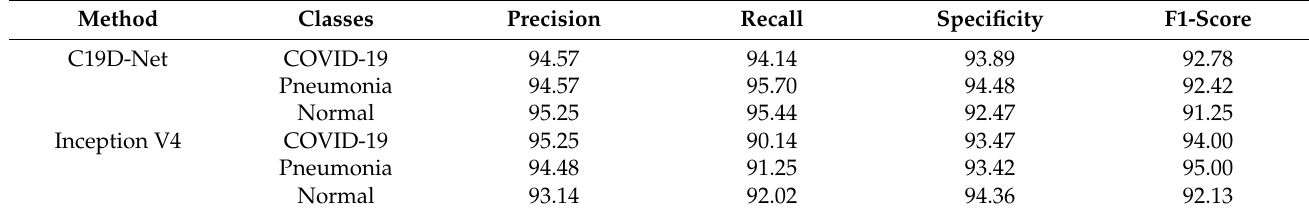
Table 6. Evaluation of three-class C19D-Net,